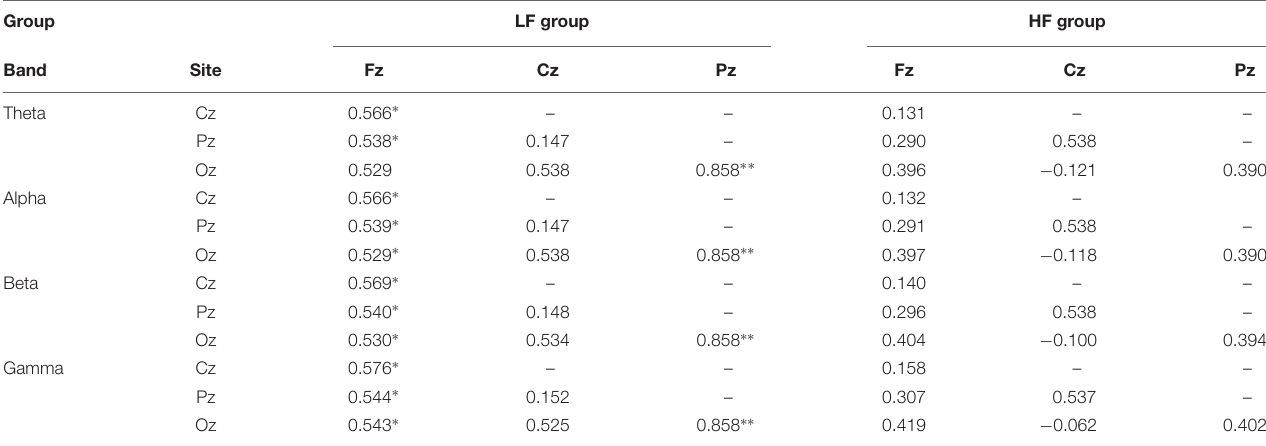
TABLE 2 | Pearson’s correlation coefficient analysis of the PSD between posture-related cortex regions during the platform recovery phase with virtual reality interference. Group LF